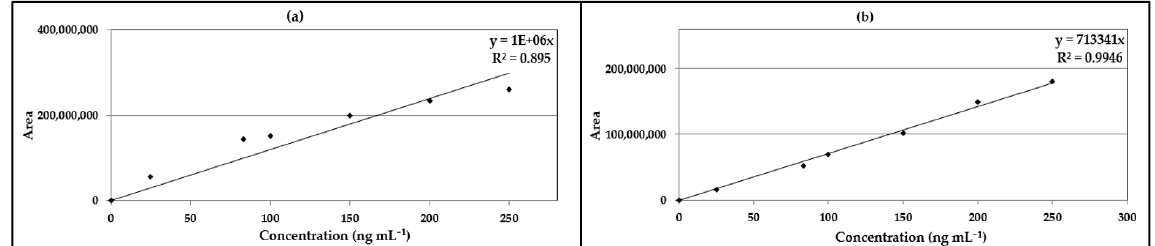
Figure 6. Calibration curve in MeOH of [M-H] − adduct of DNC without ( a ) and with ( b ) IS-CID of 20 eV.